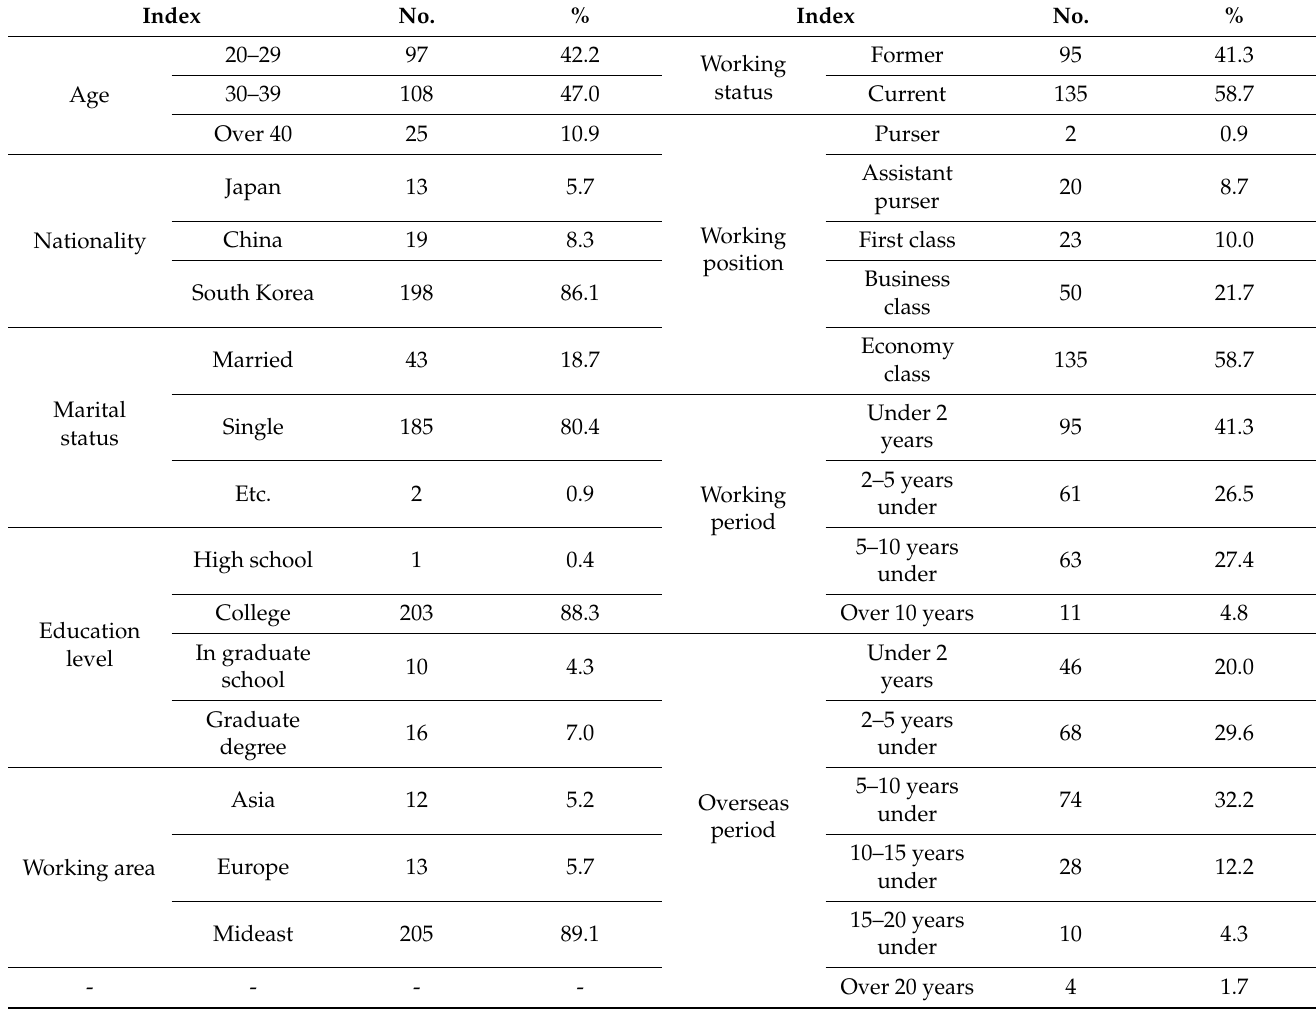
Table 4. Demographic